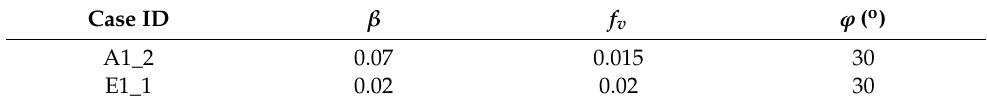
Table 2. Model calibration parameters.